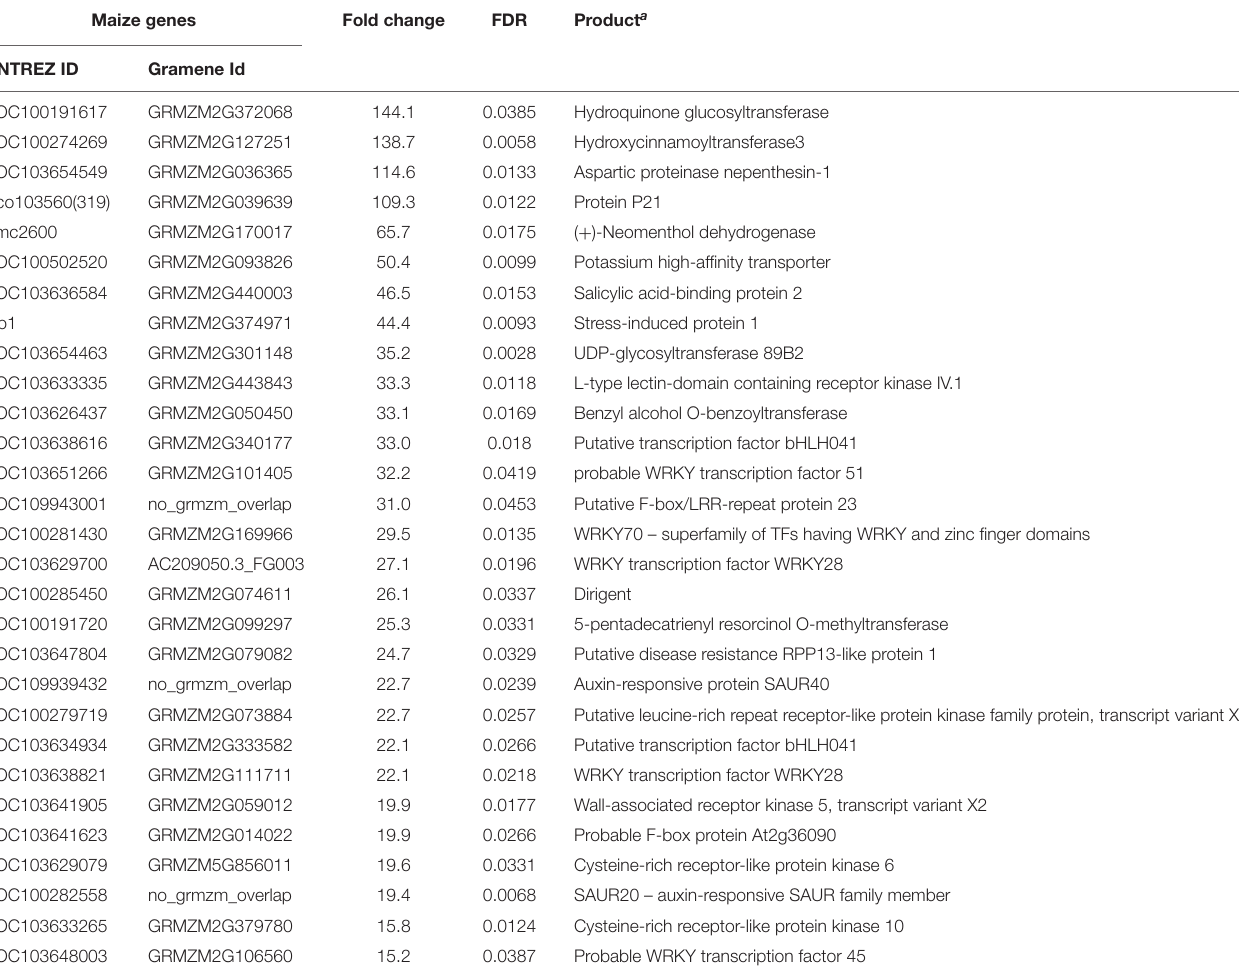
TABLE 2 | Differentially expressed genes related to defense and unique to the incompatible interaction at 72 hai in maize with fold change greater than 15 and FDR < 0.05. Maize genes Fold change FDR Product